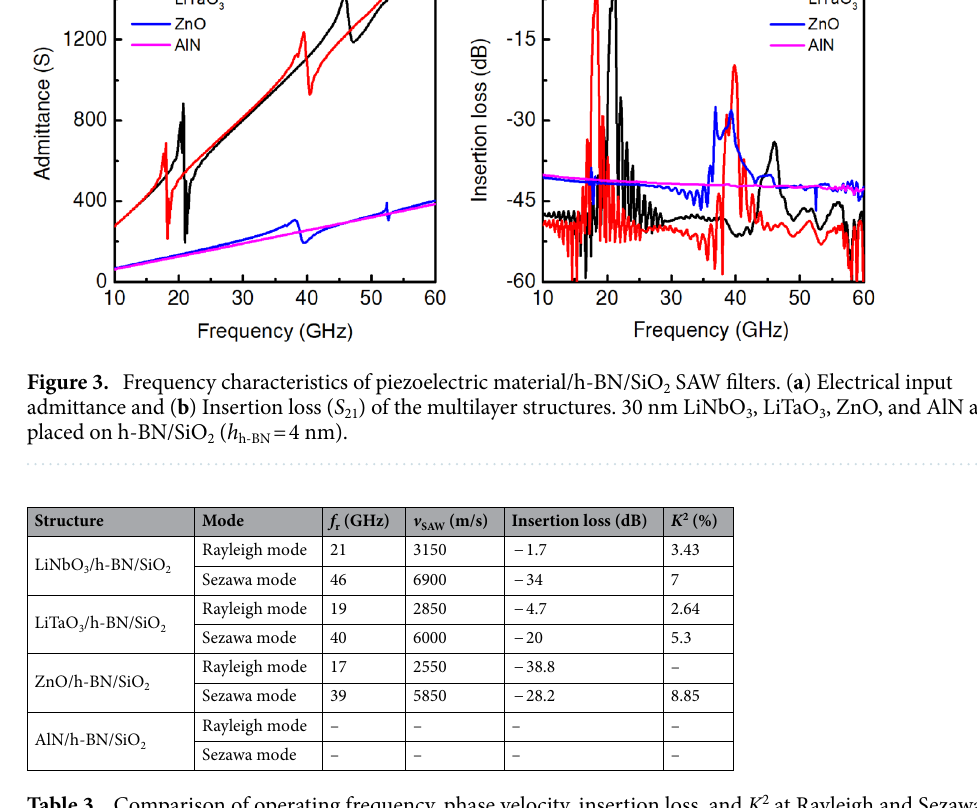
Table 3. Comparison of operating frequency, phase velocity, insertion loss, and K 2 at Rayleigh and Sezawa modes of multilayer